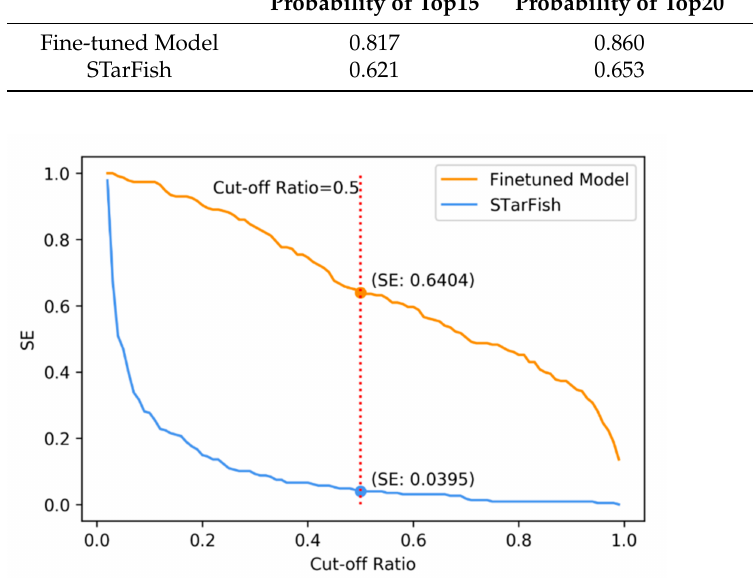
Figure 7. The effect of different cutoff ratios on the SE. The two curves correspond to the STarFish model and the fine-tuned model. The validation is carried on the same test